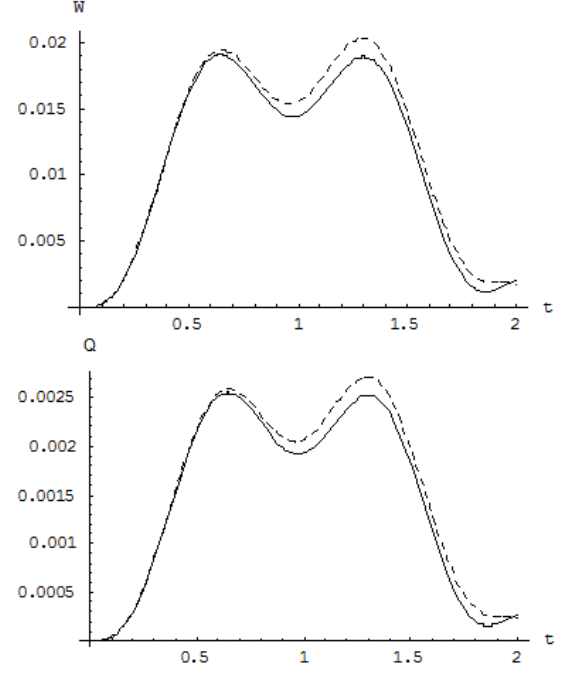
Figure 19: The influence of the load model for R = 150 m and υ = 30 m/s and ( - - - ) Concentrated load P = Mg , ( ___ ) Damped mass- load M